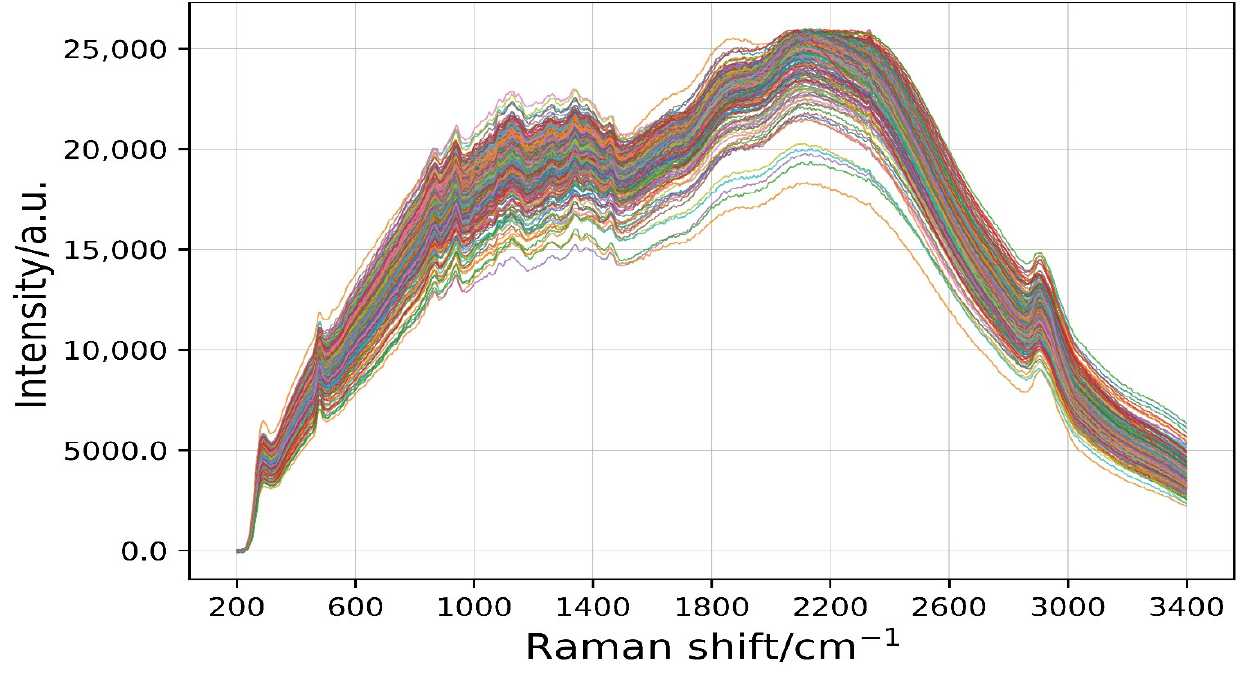
Figure 1. Four hundred and thirty-two curve of original Raman spectrum by Pro Scope HR. Raman shift is the reciprocal of wavelength, and its range is 200–3400 cm − 1 . Intensity is the intensity of Raman scattering.